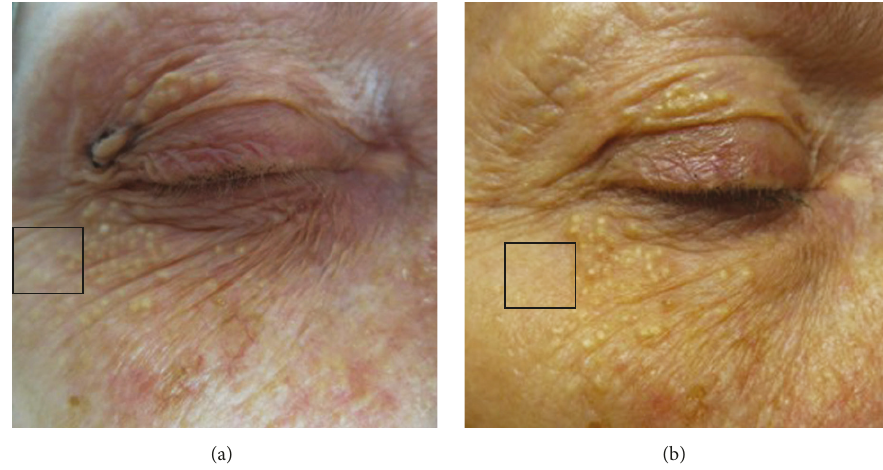
Figure 3: (a) Clinical presentation case #2, a 67-year-old female patient, presurgery. Numerous periorbital 1-2mm white and yellow papules are shown. Papules inside the highlighted region (black box) were removed surgically. (b) Clinical presentation case #2, one year after surgery. No recurrence of removed papules was observed (boxed region).